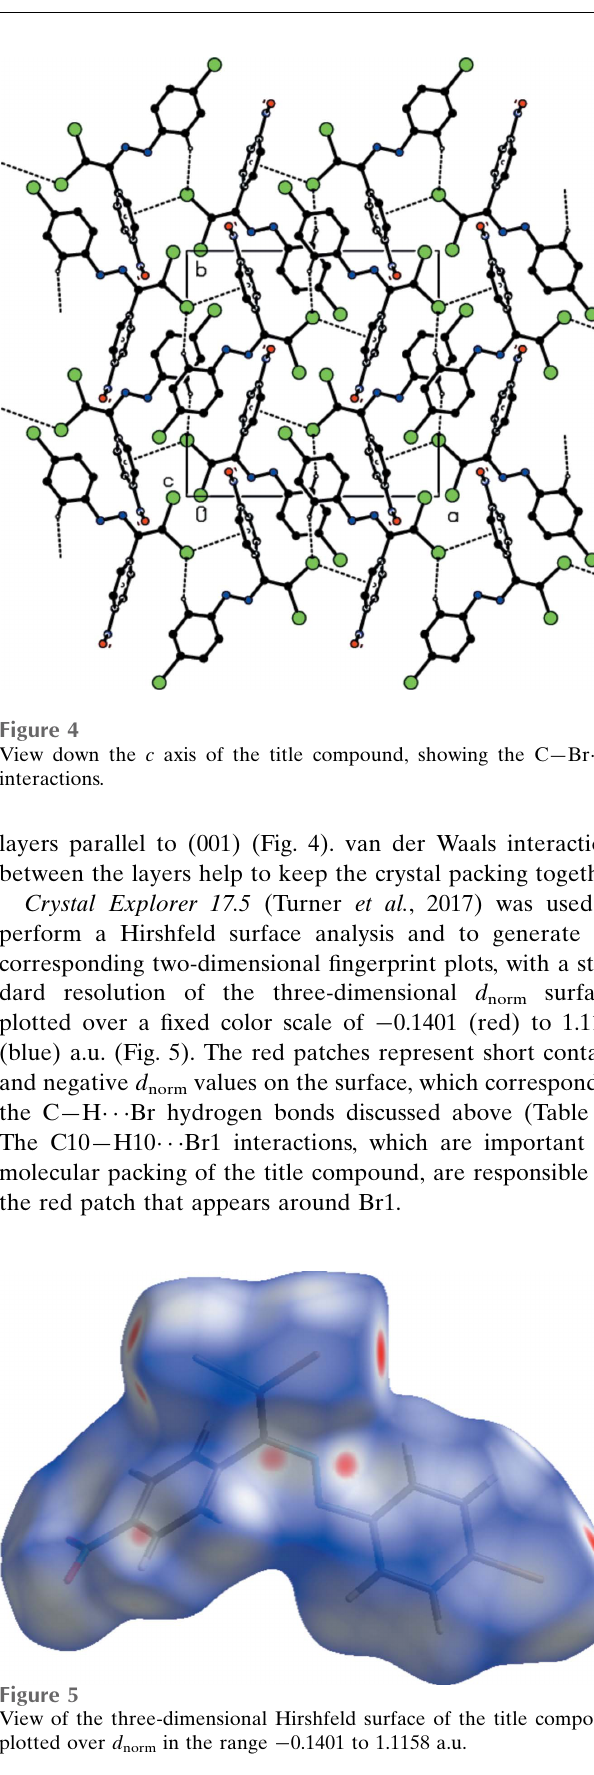
Figure 5 View of the three-dimensional Hirshfeld surface of the title compound plotted over d norm in the range (cid:4) 0.1401 to 1.1158 a.u.